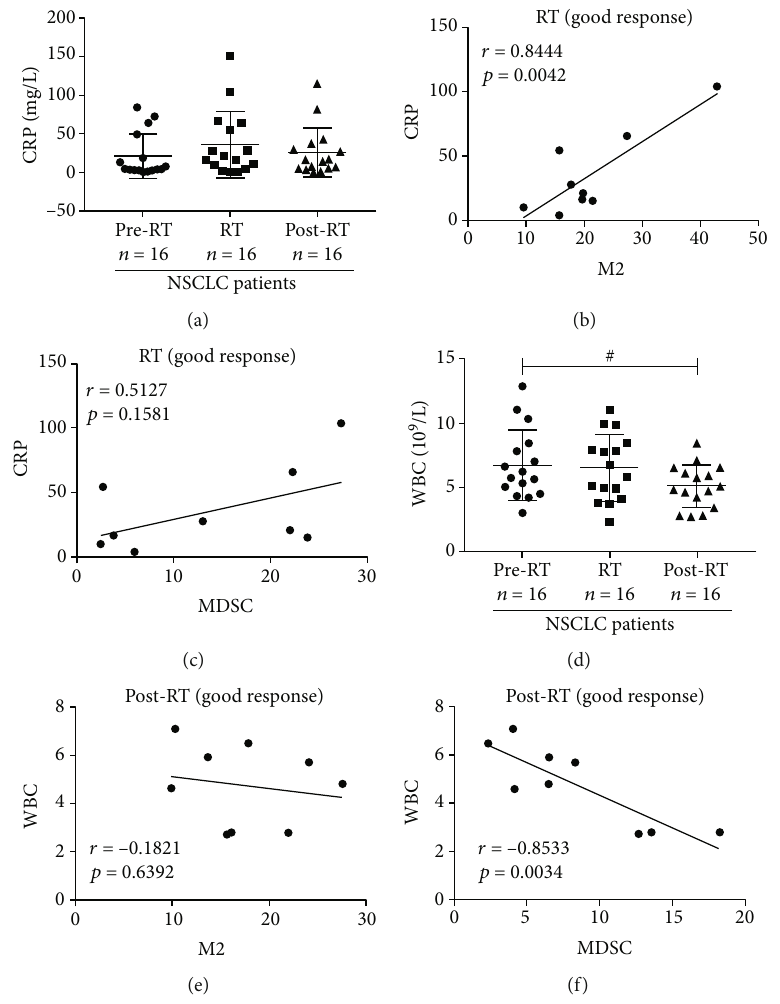
Figure 6: The crossed correlation analysis of CRP and WBCs with MDSCs and CD68 + CD163 + M2-like macrophages in NSCLC patients. (a) The bar graph of the expressions of CRPs in NSCLC patients of pre-RT, RT, and post-RT groups. (b, c) The correlation of CRPs of the good response group with CD68 + CD163 + M2-like macrophages and MDSCs of NSCLC patients during radiotherapy. (d) The plot of the expressions of WBCs in NSCLC patients of pre-RT, RT, and post-RT groups. (e, f) The correlation of WBCs of the good response group with CD68 + CD163 + M2-like macrophages and MDSCs of NSCLC patients after radiotherapy. # p < 0 : 05 . Data were analyzed by Pearson ’ s correlation